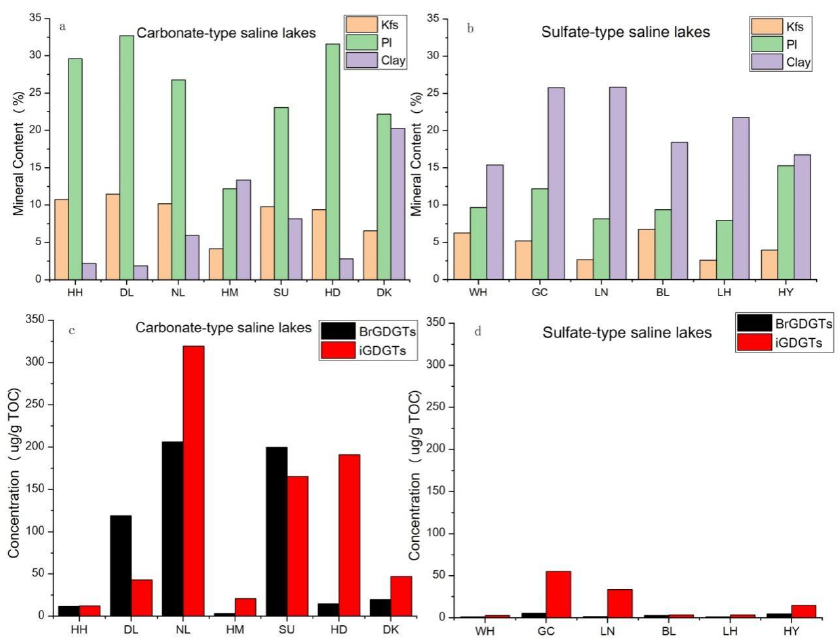
Figure 8. Comparison of mineral composition and concentration of GDGTs for 13 surface sediments. ( a ). mineral content of carbonate-type saline lake sediments; ( b ). mineral content of sulfate-type sa- line lake sediments; ( c ). GDGT concentrations in carbonate-type saline lake sediments; ( d ). GDGT concentrations in sulfate-type saline lake sediments.) (Kfs, K-feldspar; Pl, plagioclase.).